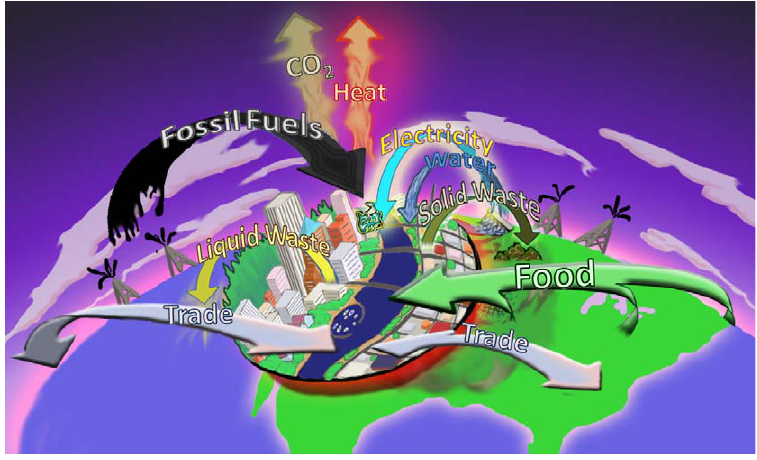
Figure 2. Pictorial illustration of important flows of resources into and wastes out of Portland, Oregon. This ‘‘most sustainable city in America’’ depends on exchanges with the local, regional, and global environments and economies in which it is embedded.